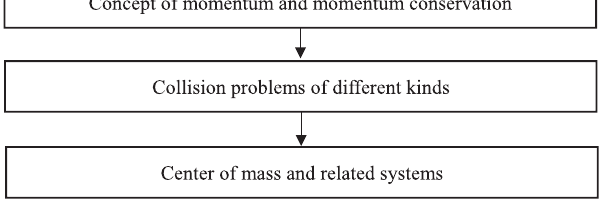
FIG. 10. The process of instruction on momentum in the U.S. university in this